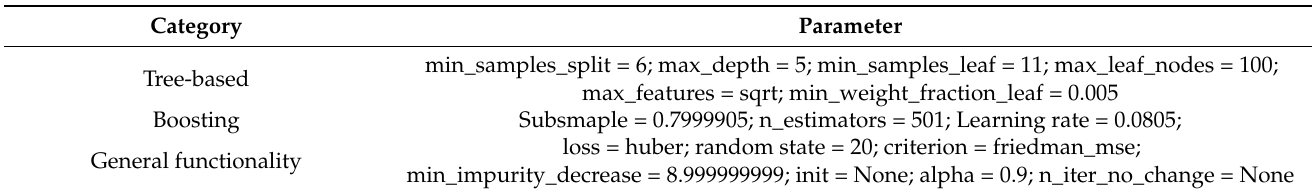
Table 5. Optimised parameters of GB